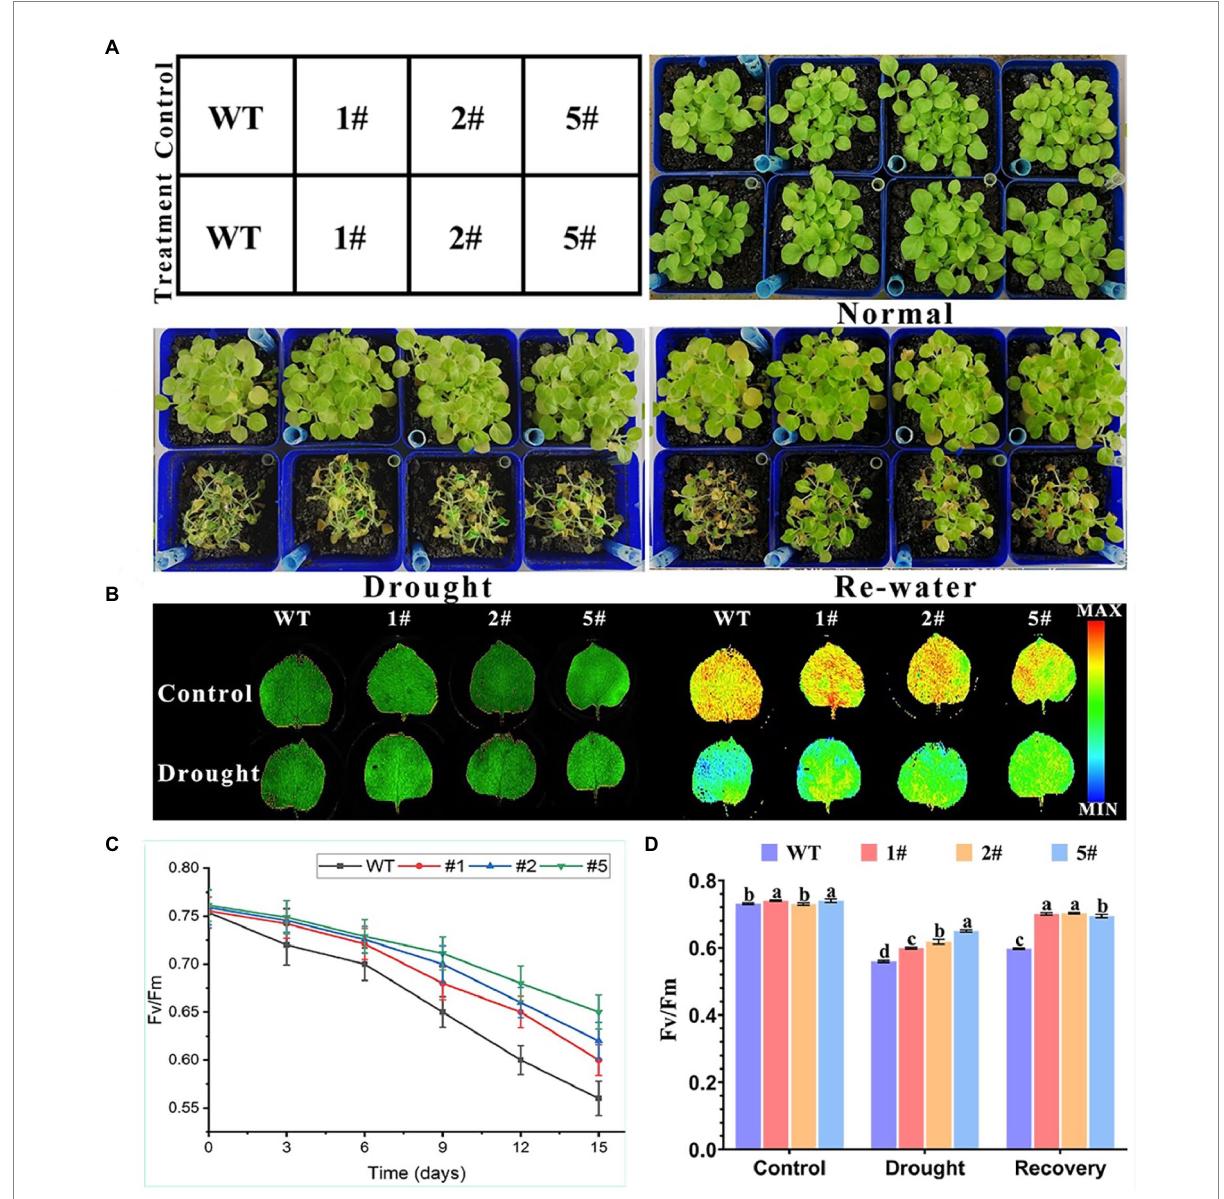
FIGURE 8 Overexpression of AfNAC1 improves the resistance of tobacco to drought stress. (A) Tobacco phenotypes of transgenic tobacco before drought treatment, under drought treatment, and after re-watering treatment. (B) RGB image on the left, chlorophyll fluorescence parameter image on the right. (C) Fv/Fm values of a strain overexpressing AfNAC1 and wild-type plants at days 0, 3, 6, 9, 12, and 15 after watering was stopped. (D) Control, drought treatment, and 3 days after watering were resumed. Fv/Fm values of wild-type tobacco WT compared with those of tobacco overexpressing AfNAC1 ; Error lines indicate standard errors of three biological replicates with significant differences at the p < 0.05